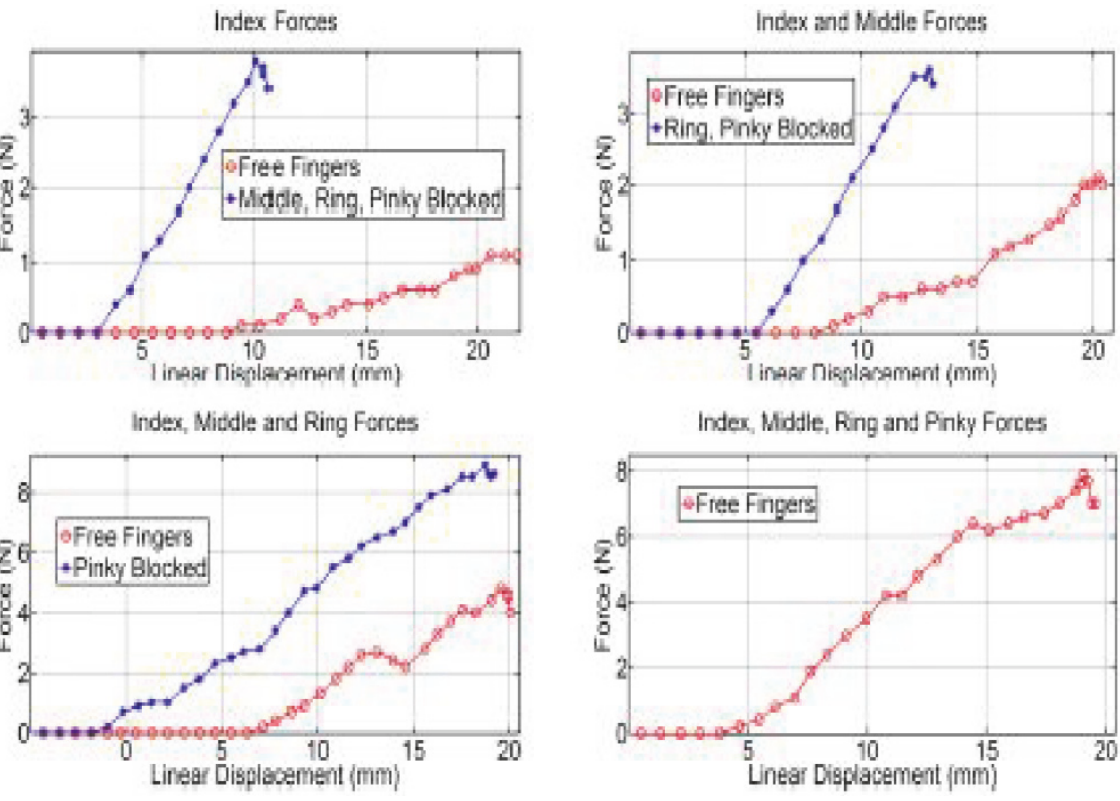
Figure 11: Linear displacement of fingers.